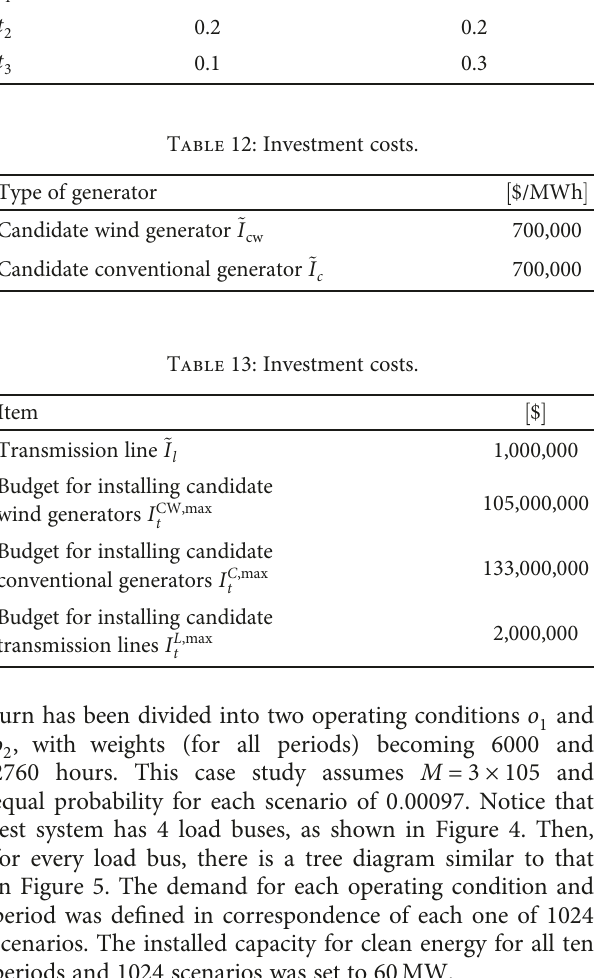
Table 8: Data for existing and candidate